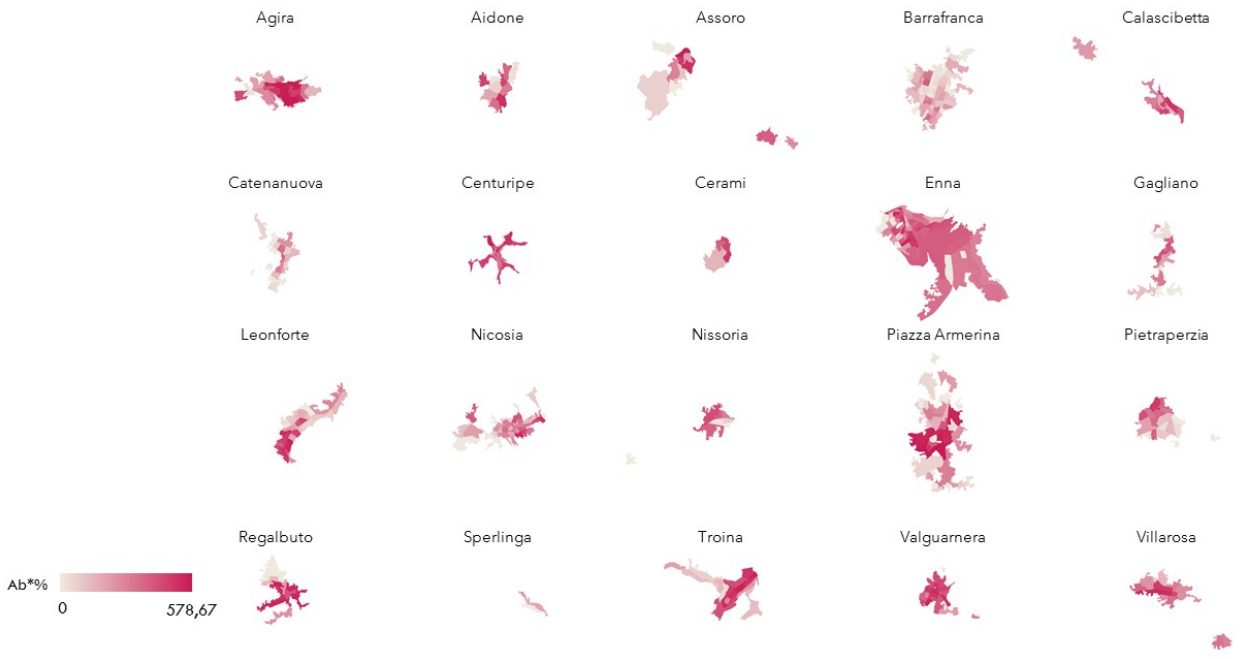
Figure 7. Map of the Testimonial Value on the scale of the Census Sections in the 20 towns of the Enna Province. The Testimonial Value is the product of the number of residents and the percentage of residential buildings erected prior to 1945. This index measures the degree of preference for the historic center. A darker red colour corresponds to a higher